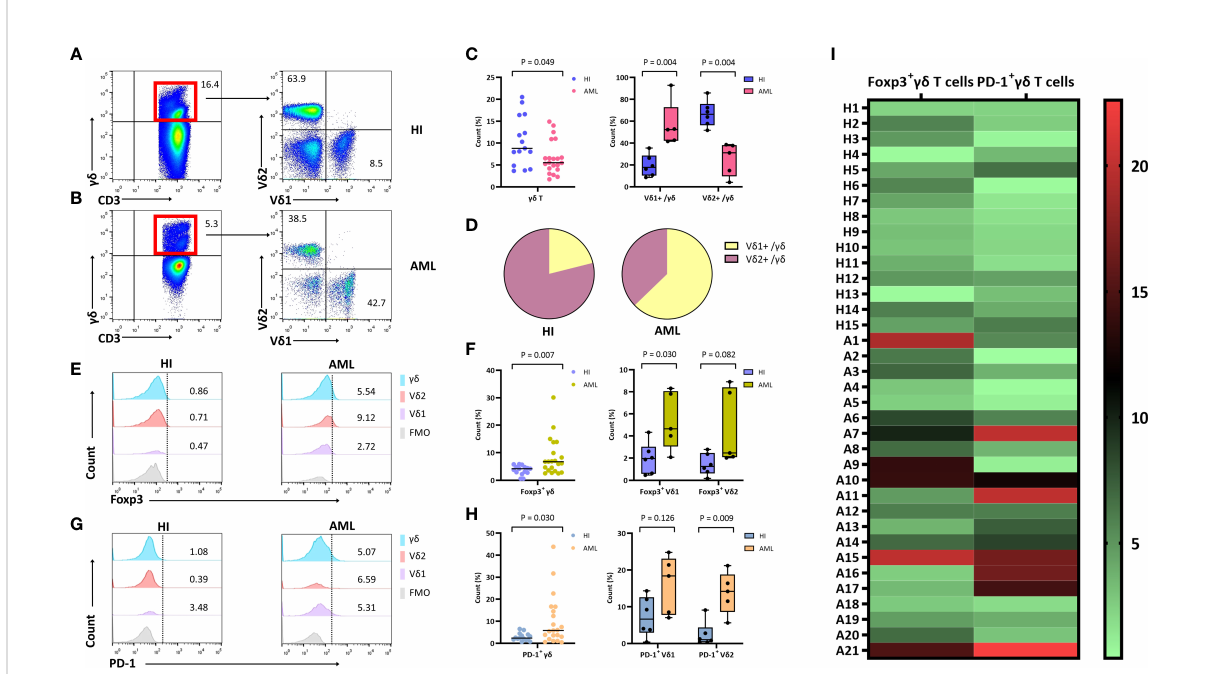
FIGURE 2 Distribution and frequency of Foxp3 and PD-1 expression in gd , V d 1, and V d 2 cell subsets in PB from patients with de novo AML. (A, B) gd T cells were gated by CD3 + T cells, further identifying V d 1 and V d 2 cell subsets from a healthy donor and a patient with de novo AML by fl ow cytometry analysis. (C) Comparison of the percentage of gd , V d 1, and V d 2 cell subsets in AML patients compared with HIs. (D) The pie chart representing the distribution of V d 1 and V d 2 cells in AML patients and healthy individuals (HIs). (E) Detection of Foxp3 expression in gd , V d 1, and V d 2 cell subsets from a healthy donor and an AML patient. (F) Comparison of the percentage of Foxp3 + gd , V d 1, and V d 2 cell subsets in AML patients compared with HIs. (G) Detection of PD-1 expression in gd , V d 1, and V d 2 cell subsets from a healthy donor and an AML patient. (H) Comparison of the percentage of PD-1 + gd , V d 1, and V d 2 cell subsets in AML patients compared with HIs. (I) Heatmap representing the frequency of the Foxp3 + and PD-1 + gd T subsets in patients with AML (A1-A21) compared with HIs